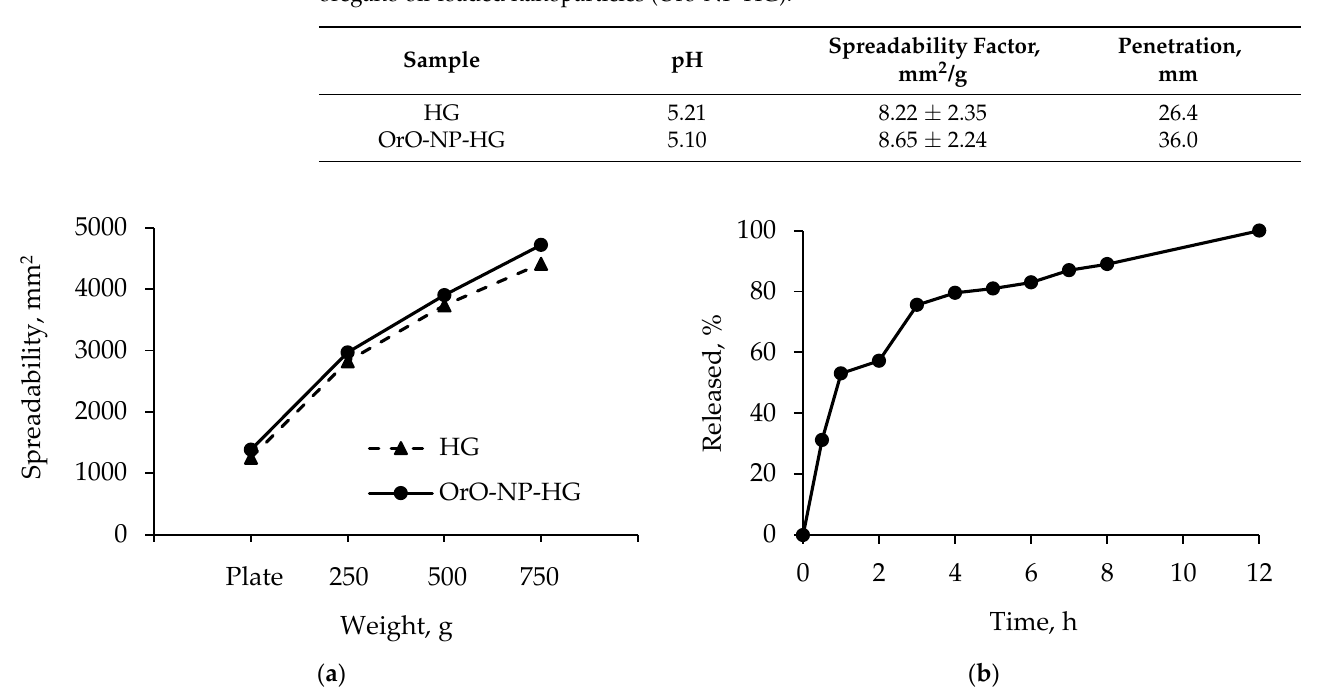
Figure 2. Spreadability of methylcellulose hydrogel (HG) and hydrogel containing the oregano oil- loaded nanoparticles (OrO-NP-HG) depending on the charging weight ( a ). In vitro release profiles of oregano oil from the hydrogel formulation ( b ).